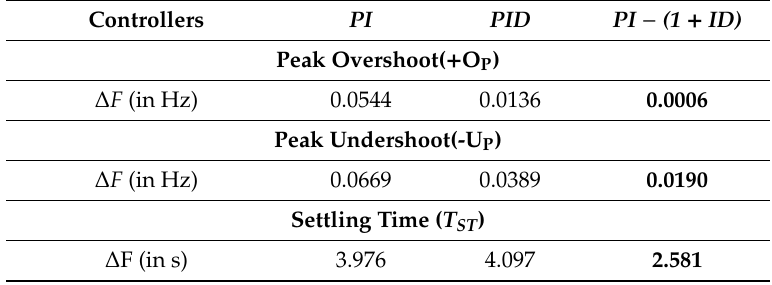
Table 2. Comparative performance parameters of di ff erent controllers with optimal BOA-tuned gain